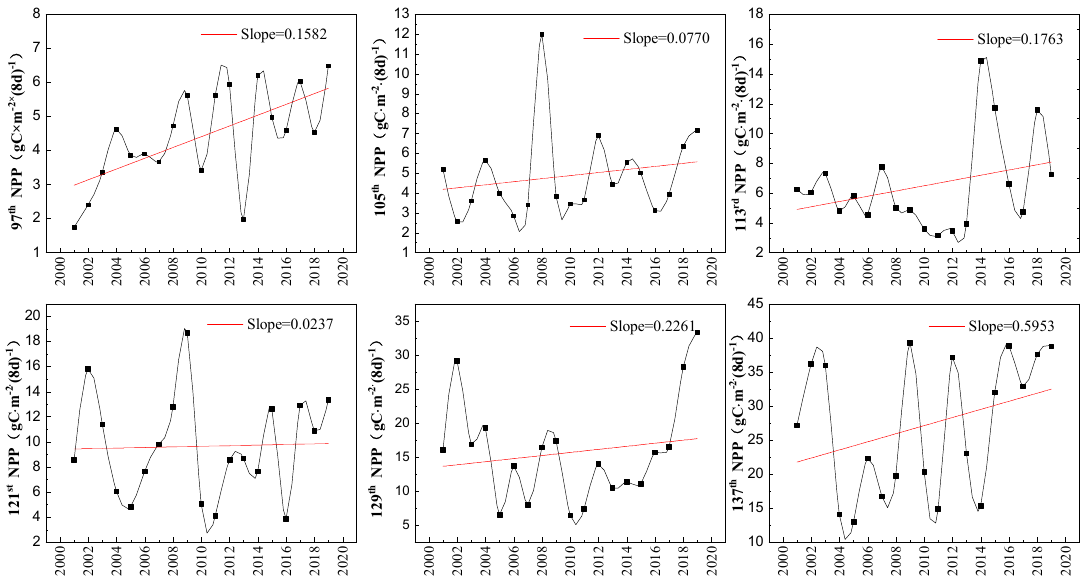
Figure 12. The variation characteristics of NPP with an eight-day cycle, in SOS, from 2001 to 2019.